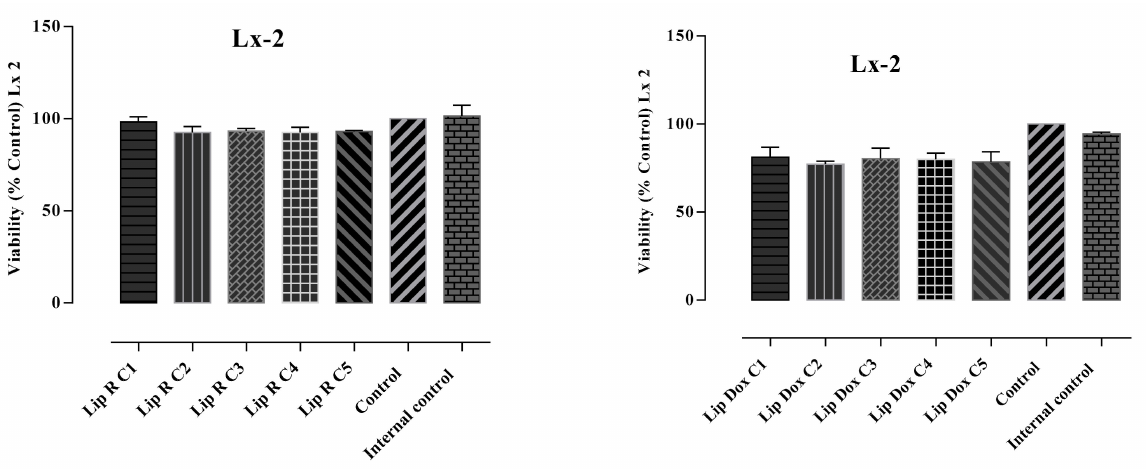
Figure 2. Antiproliferative potential of L-R and L-DOX on LX-2 cell line tested at five different concentrations of L-R calculated according to the TPC ( µ mol GAE/mL) determined for each extract (56.6 µ M, 113 µ M, 169.5 µ M, 226 µ M, and 282.5 µ M) and doxorubicin C1–C5 (1.64 µ M, 8.2 µ M, 12.3 µ M, 16.4 µ M, and 20.5 µ M). Negative control—untreated cells, internal control—L-E. Values represent the mean ± SD of three